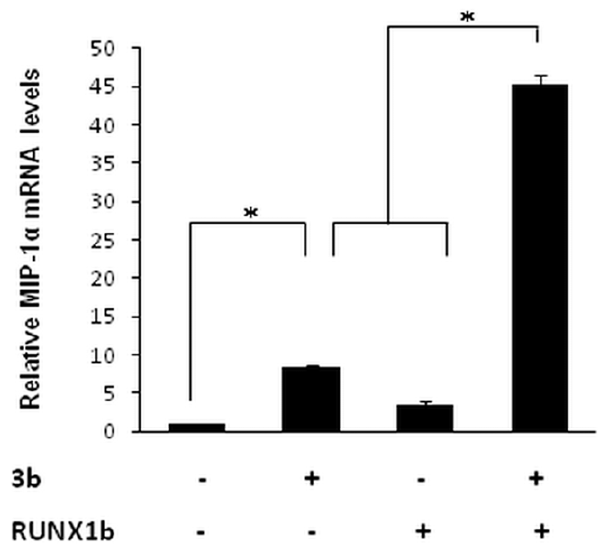
Figure 6. 3b and RUNX1b cooperatively increase MIP-1 a mRNA levels. Relative mRNA levels of MIP-1 a to actin were estimated in U937 cells expressing indicated proteins, using quantitative RT-PCR. Histo- gram is the result of three independent experiments. Bar values represent fold increase in the mRNA levels. Asterisk *, p , 0.005.